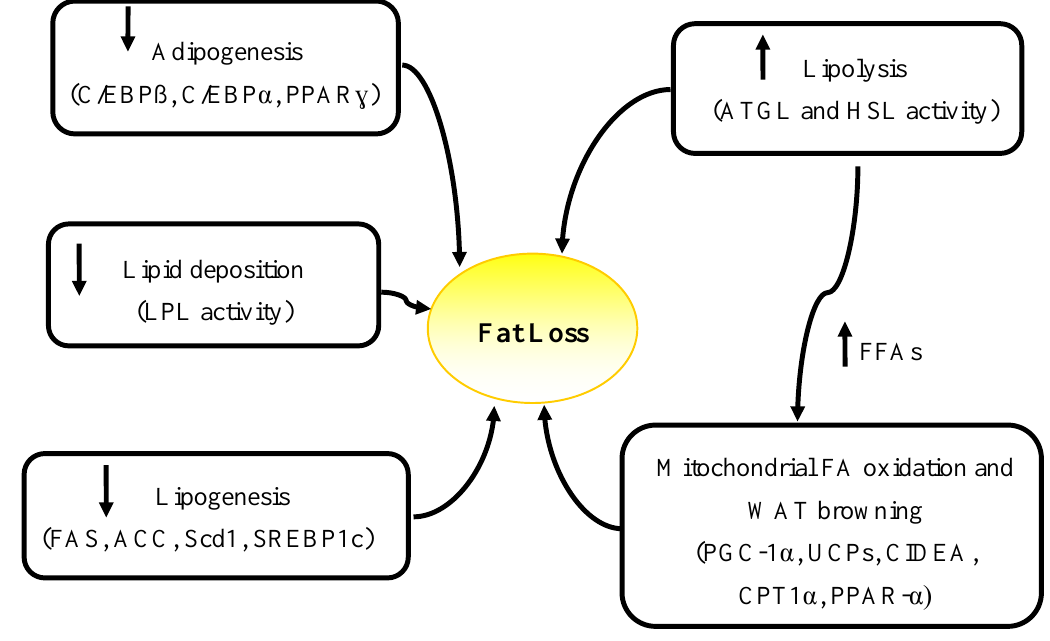
Figure 2. Summary of mechanisms and specific genes involved in adipose atrophy in cancer. WAT, white adipose tissue; FFAs, free fatty acids; ATGL, adipose triglyceride lipase, HSL, hormone sensitive lipase; PGC-1α, peroxisome proliferator-activated receptor-gamma coactivator 1 alpha; UCPs, un-coupling proteins; CIDEA, Cell death-inducing DFFA (DNA fragmentation factor-alpha)-like effector A; CPT1α, carnitine palmitoyltransferase 1 alpha; PPAR-γ, Peroxisome proliferator-activatedreceptor gamma; C/EBPα, CCAAT-enhancer- binding proteinα; LPL, lipoprotein lipase; FAS, fatty acid synthase; ACC, Acetyl-CoA carboxylase; Scd1, Stearoyl-CoA desaturase; SREBP1c, sterol regulatory element binding